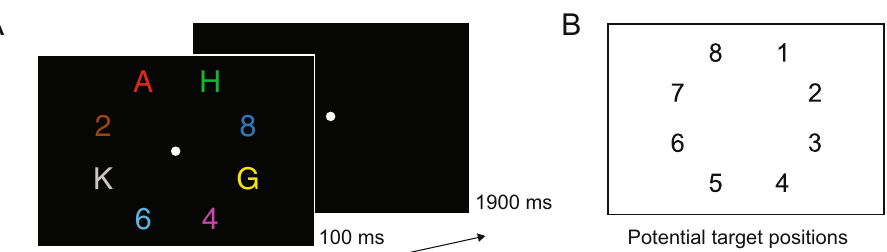
Figure 2. Task and conditions in Experiment 2. ( A ) Trial time line of Experiment 2. Subjects were asked to determine the identity of a coloured target (letter or digit), target colour could be red, green or blue (counterbalanced across subjects). ( B ) Positions used in Experiment 2, counted clockwise, one position contained the target, the other positions were occupied by